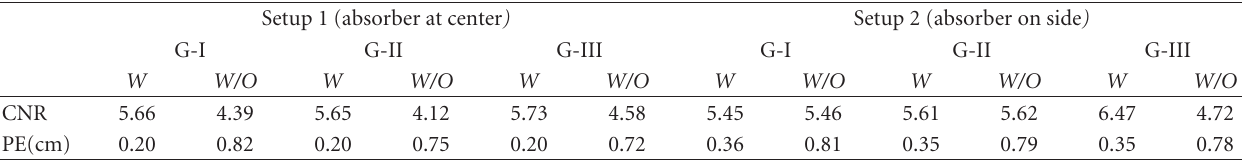
Table 1: Summary of the CNR and PE values for three geometries.